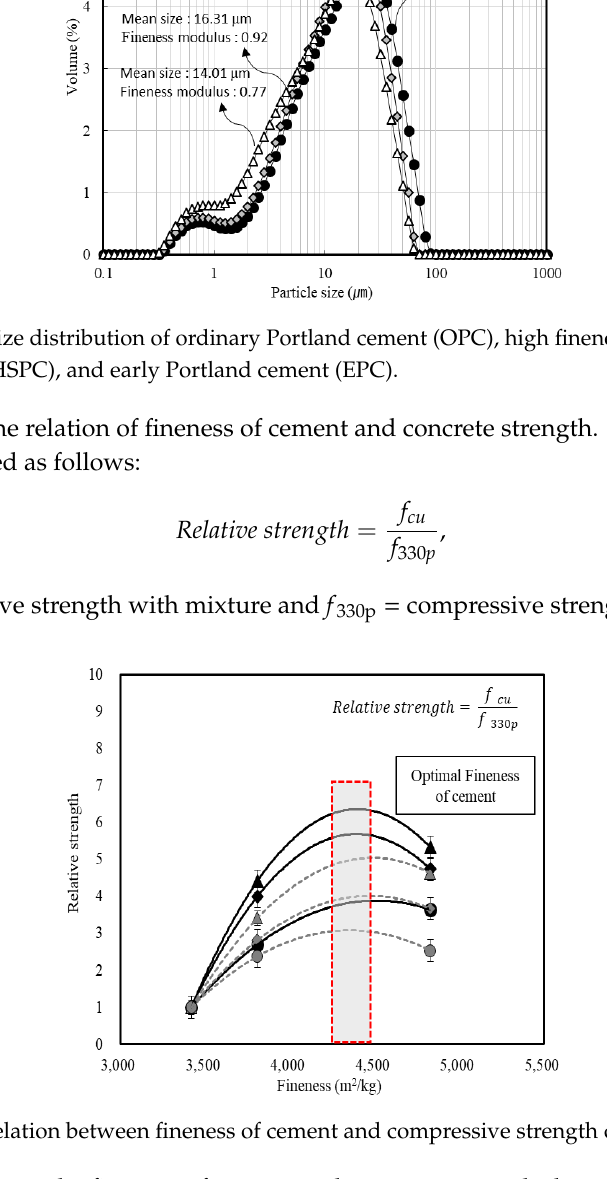
Figure 6. Relation between fineness of cement and compressive strength development.